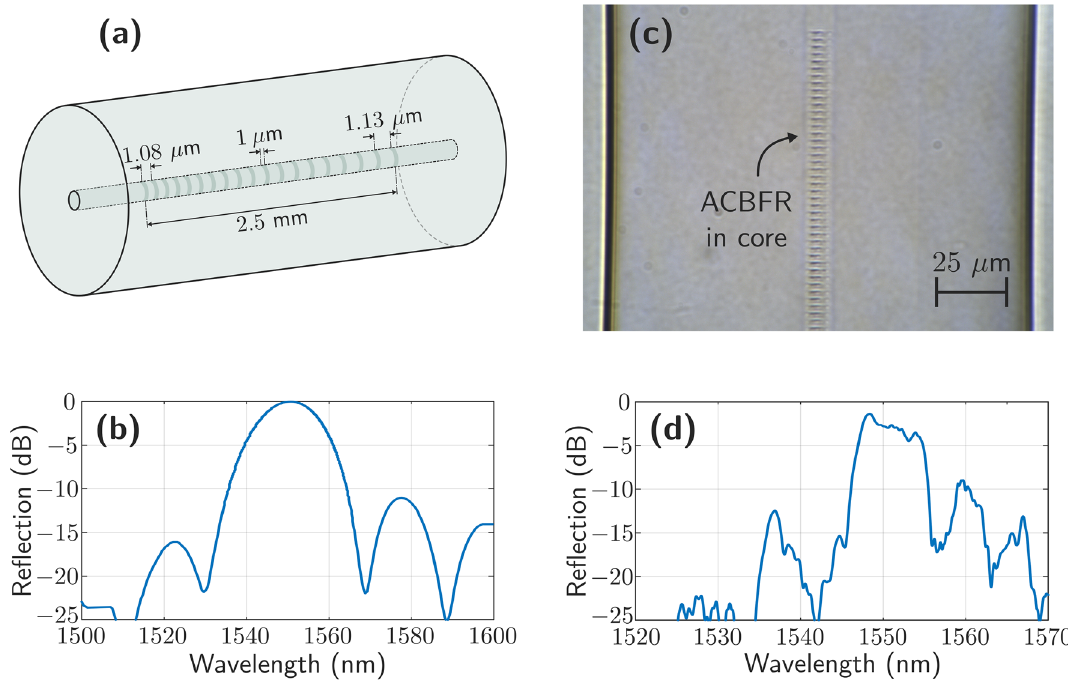
Figure 1. ( a ) Schematic of the calculated chirped ACBFRs. ( b ) Simulated output spectrum of the chirped ACBFR. ( c ) Microscope image of the manufactured ACBFR. ( d ) Output spectrum of the manufactured chirped ACBFR measured by an optical spectrum